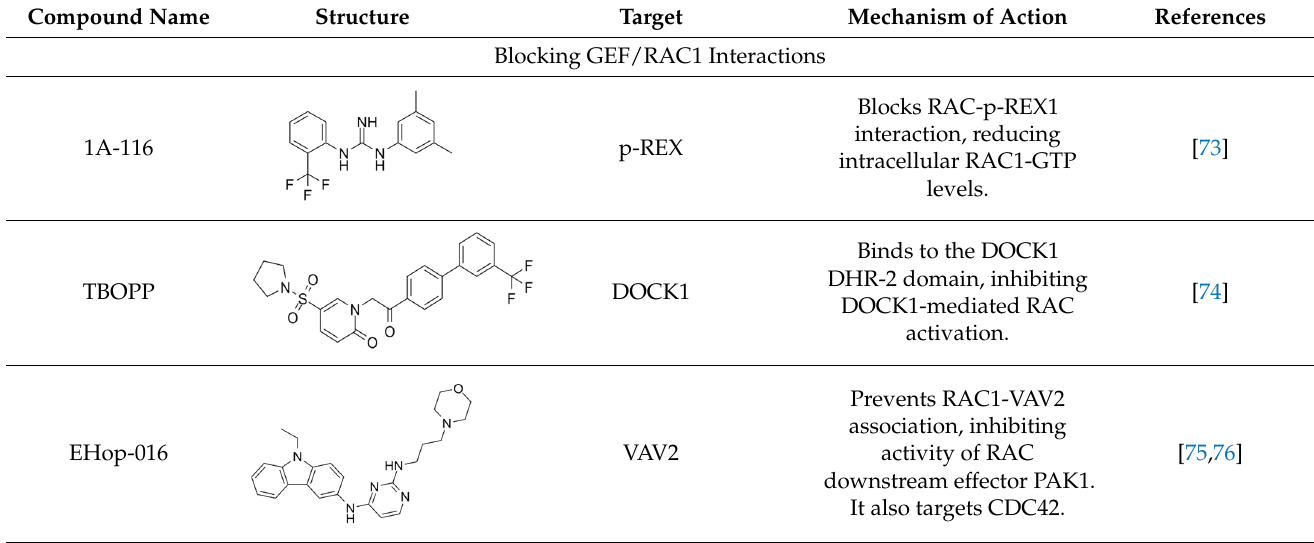
Figure 2. Targeting RAC1 in metastatic cutaneous melanoma. Current available inhibitors to target RAC1 pathway by blocking GEF-RAC1 interactions, lessening nucleotide binding, hampering RAC1 localization as well as by inhibiting downstream effector activity. Table 1. Compounds developed targeting RAC1.